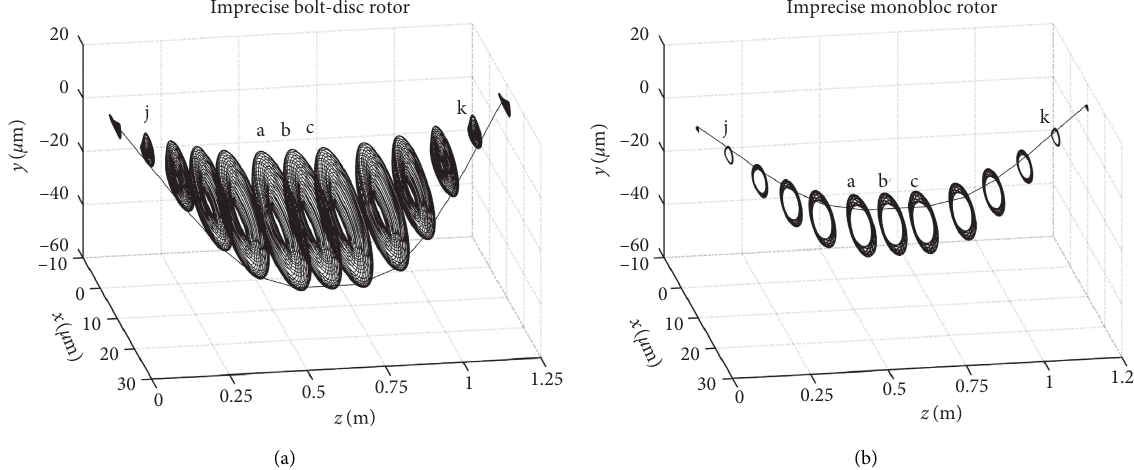
Figure 9: Dynamic motions for the both imprecise rotor: (a) quasiperiodic motion of bolt-disc rotor at 8170rpm and (b) quasiperiodic motion of monobloc rotor at